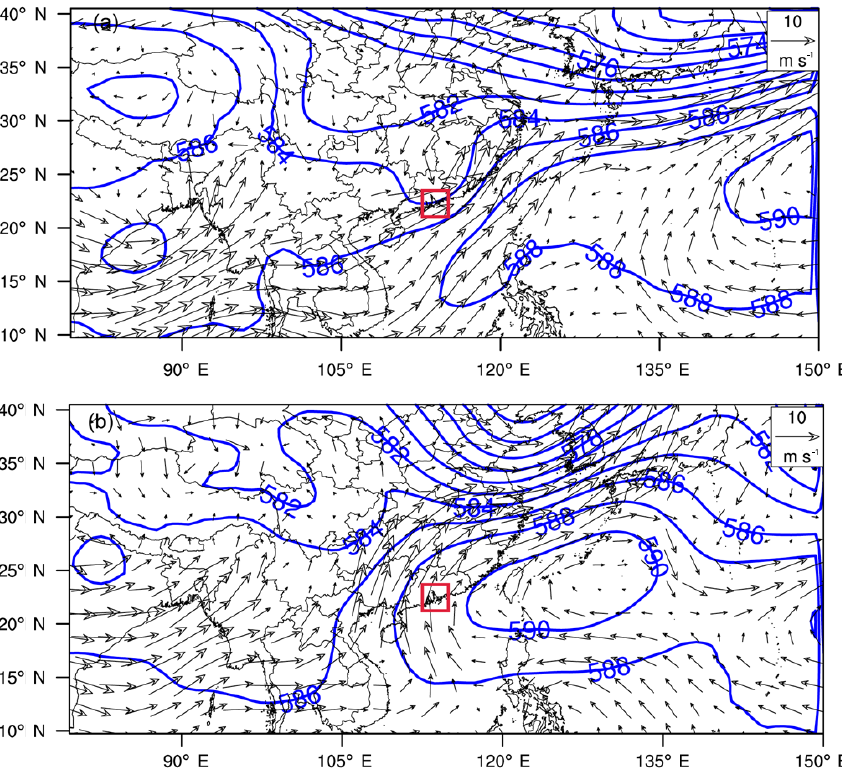
Figure 2. Spatial distribution of the wind field at 850hPa pressure level (black arrows, vector), superimposed by geopotential height at 500hPa pressure level (blue lines) averaged on 26 June 2008 (a) and 2 July 2008 (b) . All data are from the ECMWF ERA-Interim reanalysis data, and the red rectangle denotes the study